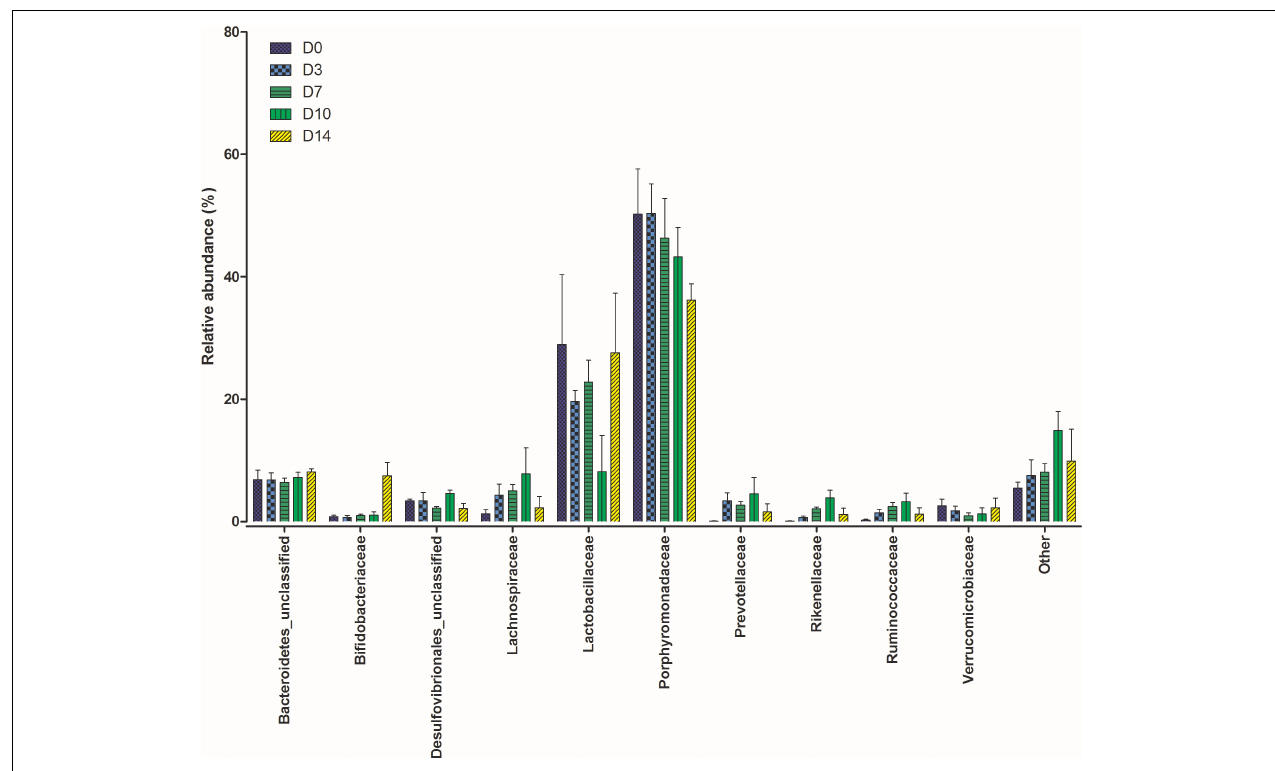
FIGURE 1 | Shifts in the relative abundance of the top 10 bacterial families present within the mouse gastrointestinal (GI) tract samples collected at five time points post